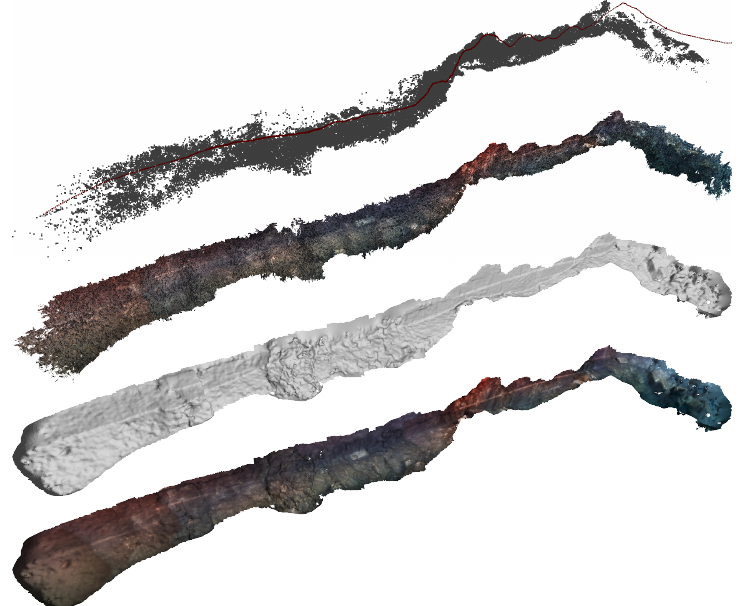
Figure 5. Different steps of the optical reconstruction for the Sant Feliu dataset. From top to bottom, the trajectory of the cameras in red—optimized, corresponding to that of Figure 4d—and the sparse point set resulting from the SFM process, the densified point set, the reconstructed surface and the texture mapping on this last